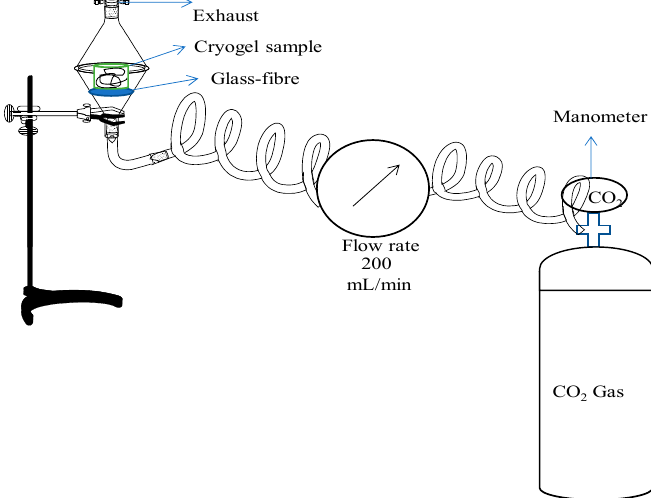
Figure 3. The schema of the presentation of CO 2 gas exposure on PEI-based cryogels and composites.